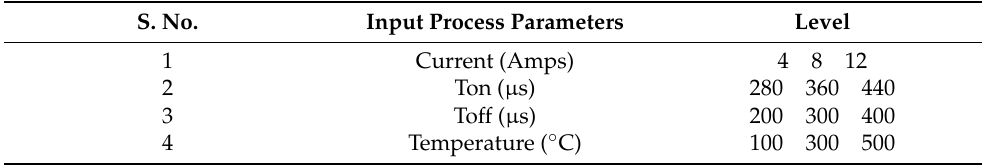
Table 2. EDM Input process